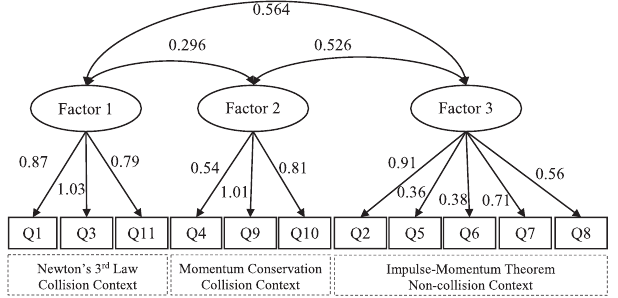
FIG. 3. Factor loadings for EFA of U.S. students ’ post-test with three-factor solution in which factors 1 to 3 are matched with the assessment design of content and context categories of Newton ’ s third law questions, typical momentum conservation questions, and atypical questions for the impulse-momentum